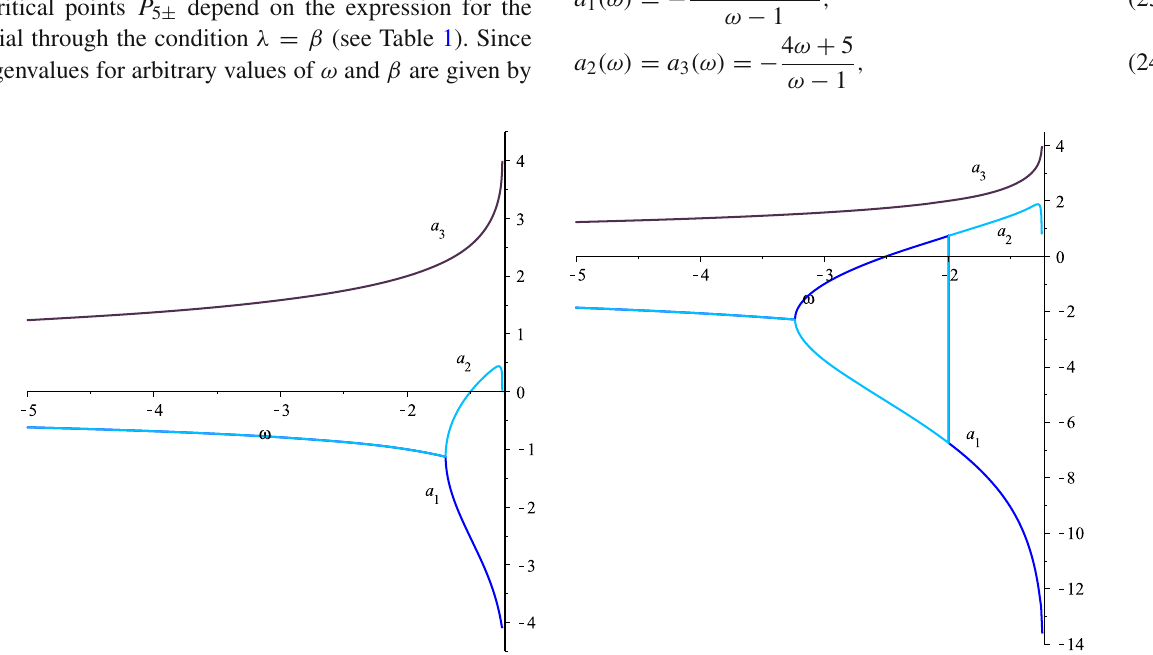
Fig. 3 Real parts of the eigenvalues corresponding to P 5 + , for n = 2 (left), and n = 4 (right). The latter shows a discontinuity for ω = − 2. The plots for a 1 and a 2 are superposed for ω (cid:3) − 1 . 7 (left) and ω (cid:3) − 3 . 2